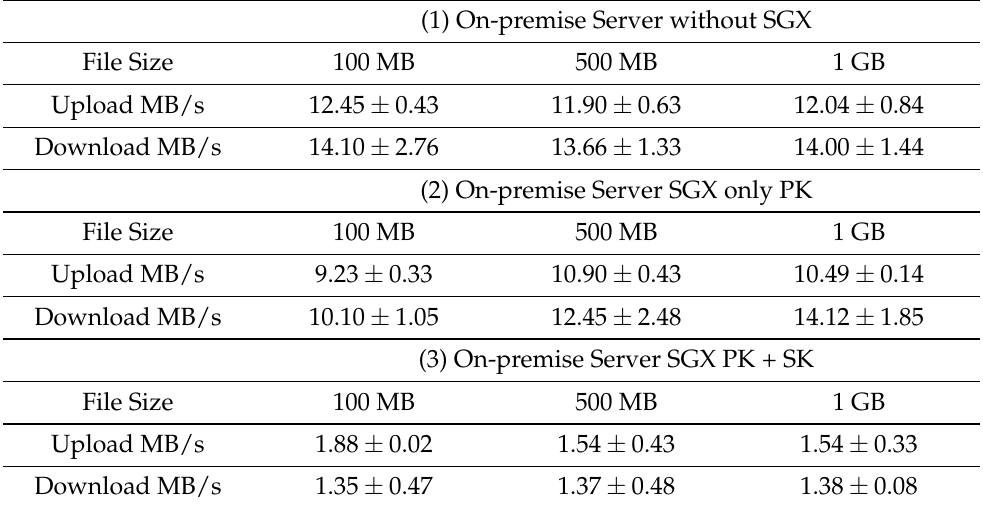
Table 4. SGX overhead testing in